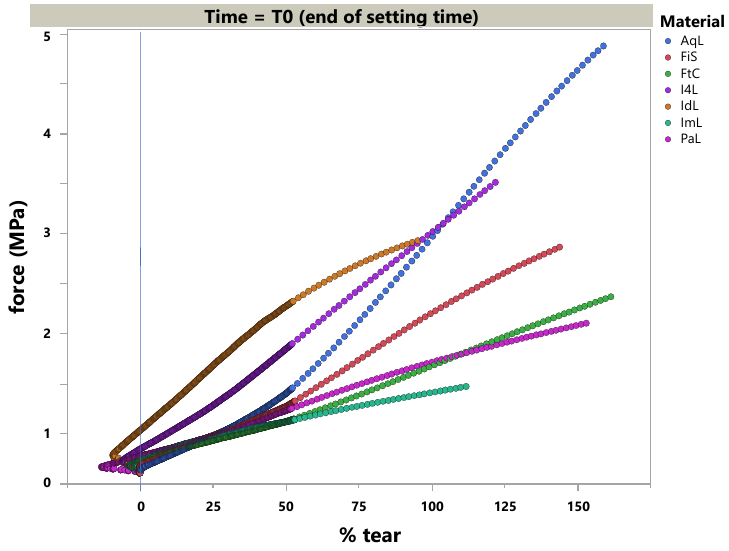
Figure 7. Stress–strain diagram of the light-body materials at the end of setting time (T0.)